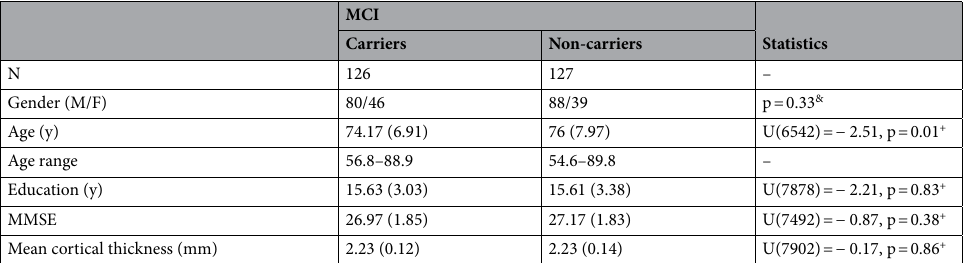
Table 1. Demographics and neuropsychological variables for MCI groups. Age, Education, MMSE, and Mean cortical thickness values are represented by means and standard deviations. Gender (M/F) is represented by the number of subjects. Significant set at p < 0.05. The superscripts “ & ” represents χ 2 test; “ + ” represents